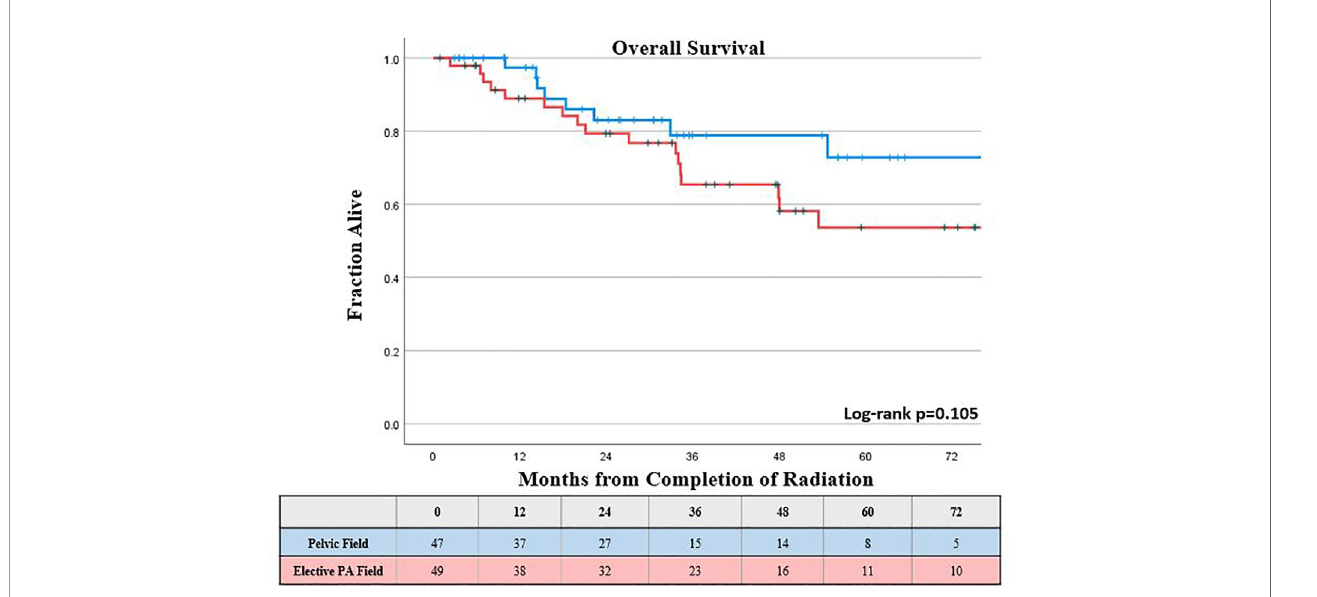
FIGURE 1 | Kaplan-Meier estimated overall survival by type of treatment fi